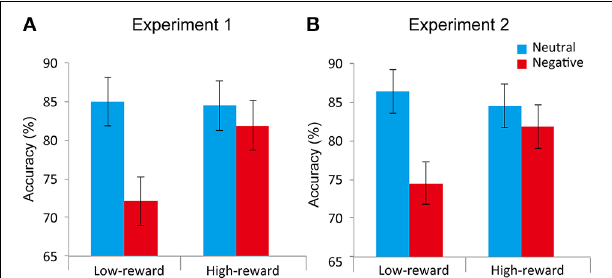
relative to neutral ones. This difference was reduced during the high-reward target condition. Error bars denote the standard within-subject error term for interaction effects (Loftus and Masson,